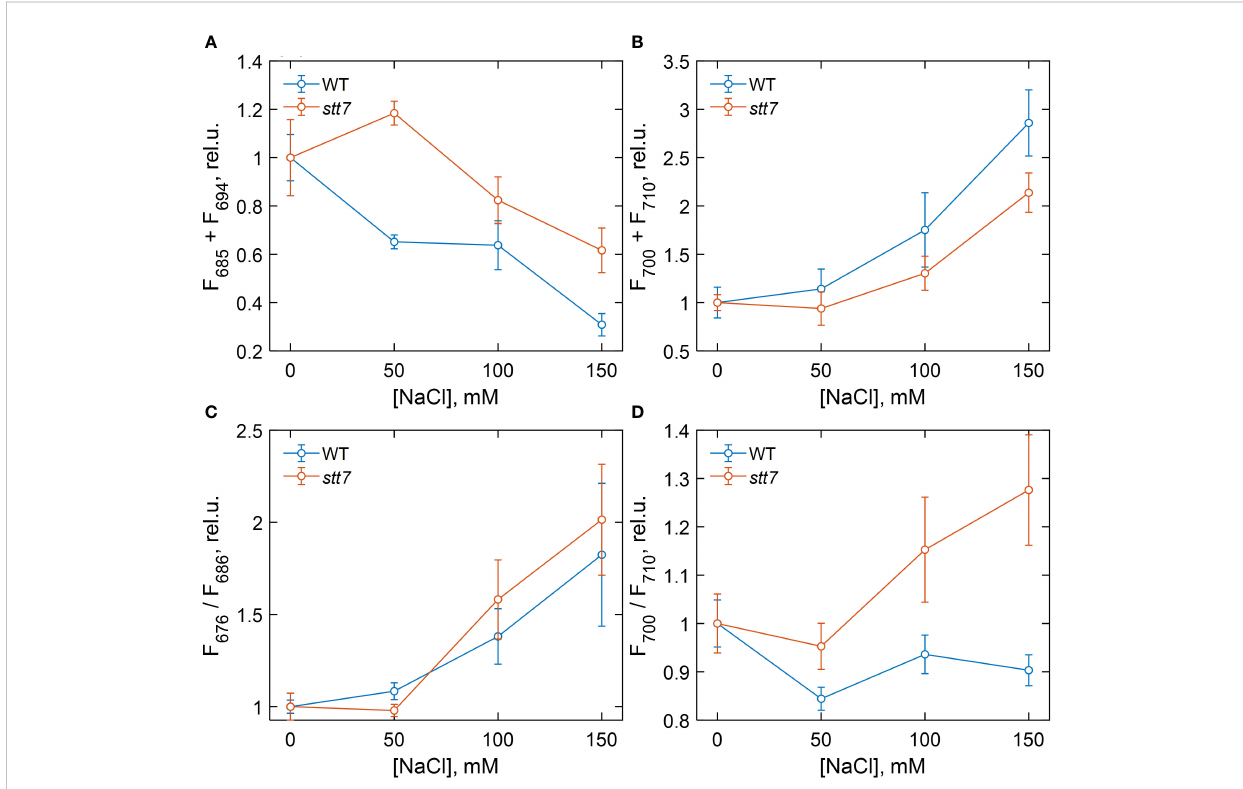
FIGURE 3 Dependence of different 77 K fl uorescence emission parameters of wild-type (WT) and state transition kinase 7 ( stt7) cells on the sodium chloride (NaCl) concentration of growth medium, relative to the salt-free control group. (A) Sum of F685 and F694; (B) sum of F700 and F710; (C) F676 relative to F686; (D) F700 relative to F710. The values are calculated from the areas of the corresponding Gaussian components normalized to the total area under the fl uorescence curves (except for F676, which is normalized to F685) and plotted relative to the corresponding value in the control. Symbols and bars indicate mean and standard error, n = 3 – 6. The closed symbols represent statistically signi fi cant differences (p < 0.05) with the respective control (0 mM), based on multiple comparison